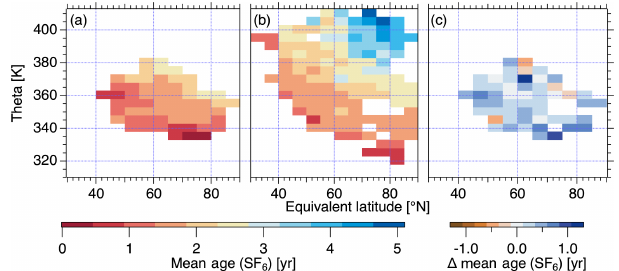
Figure 3. Distributions of mean age from SF 6 measurements in potential temperature – equivalent latitude coordinates for PV > 7PVU. Panel (a) shows data for phase 1, (b) for phase 2 and panel (c) shows their absolute difference (phase 2 − phase 1). The colour code represents the mean age. Blue colours in panel (c) indi- cate an increase in mean age in the subvortex region from January to March. Only bins with more than 10 data points are